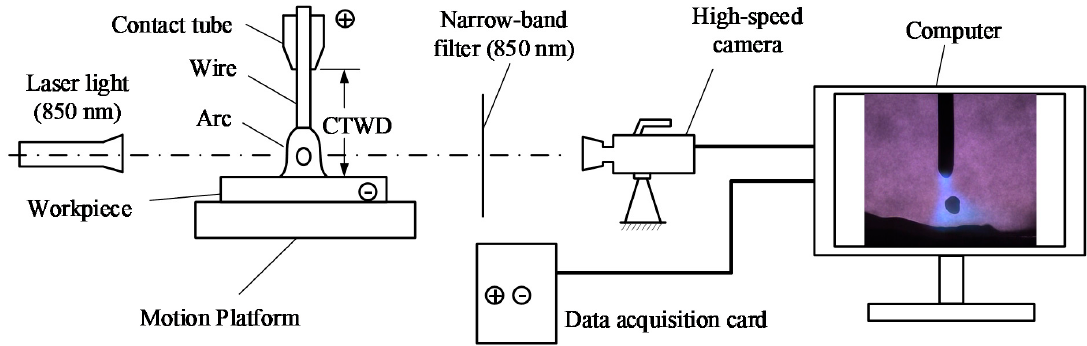
Figure 1. The schematic diagram of the welding and high-speed camera system.